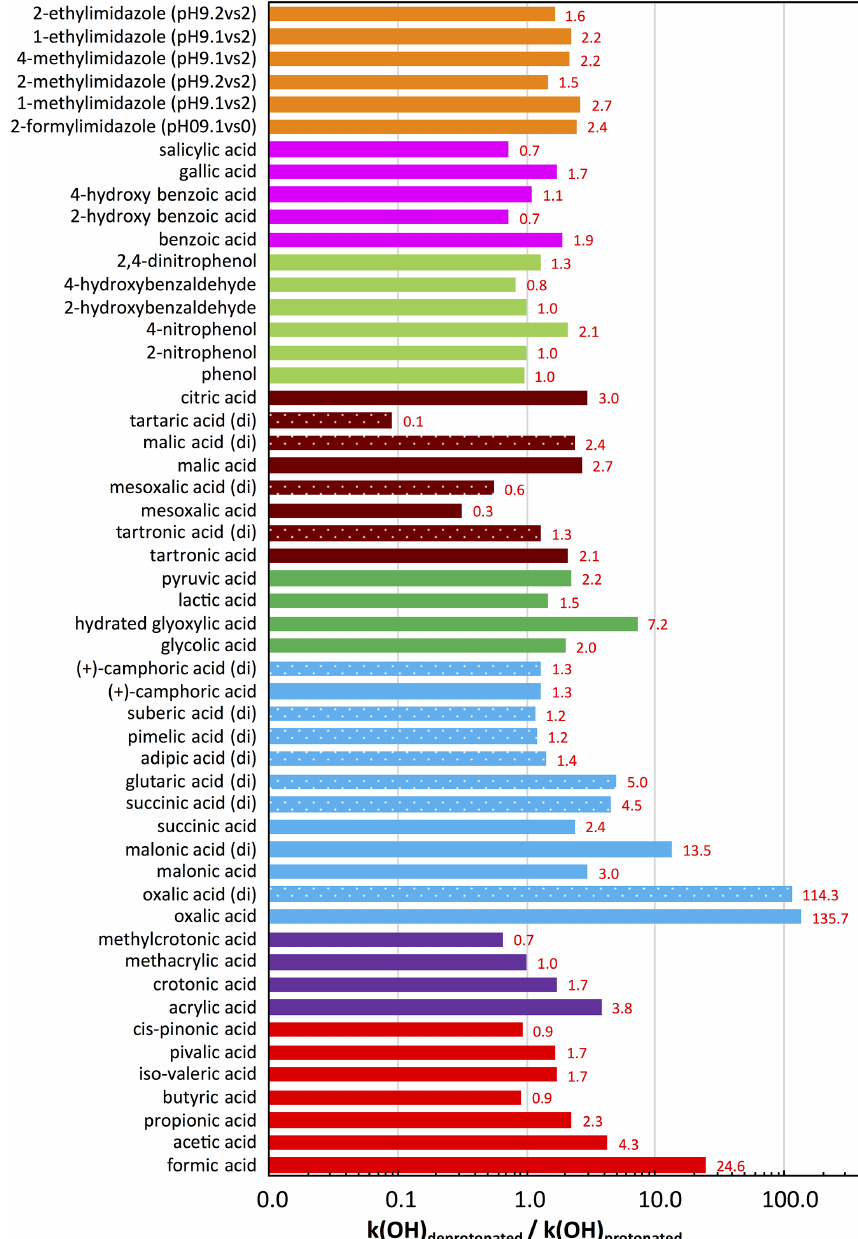
Figure 15. Calculated reactivity ratios κ R ( OH ) of different dissociating organic compounds. The κ R ( OH ) ratio of the dianion and protonated diacid is indicated by “(di)”. The applied aqueous-phase OH reaction rate constants are provided in Table S5 in the Supplement. Different colors indicate different compound classes, such as unsubstituted saturated monoacids (red), unsubstituted unsaturated monoacids (purple), unsubstituted saturated diacids (blue), substituted saturated monoacids (green), substituted saturated diacids (brown), phenols (light green), aromatic acids (pink), and imidazoles (orange). The dotted bars mark the ratio of the